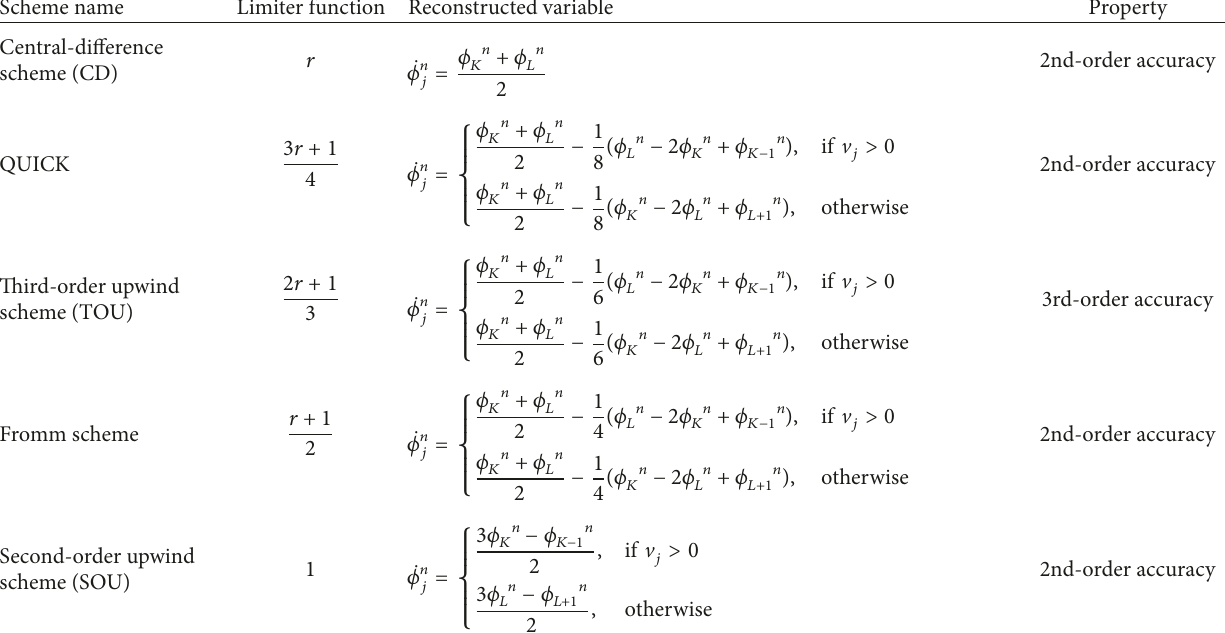
Table 1: Standard high-order linear schemes for the case of uniform